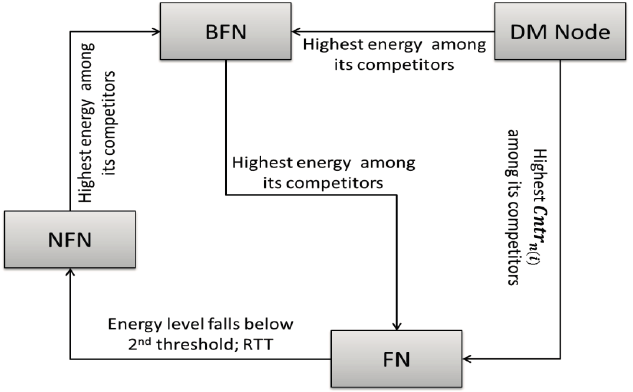
Figure 3. Different roles of network nodes in rotation of forwarding node.